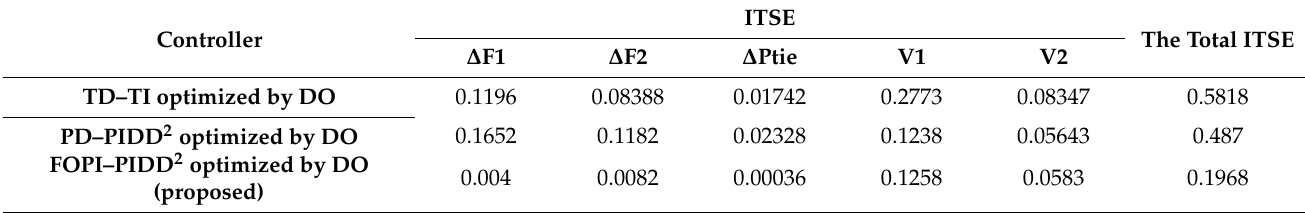
Table 4. Dynamic specifications of the investigated system represented as ITSE value using different controllers under scenario 2 impact.